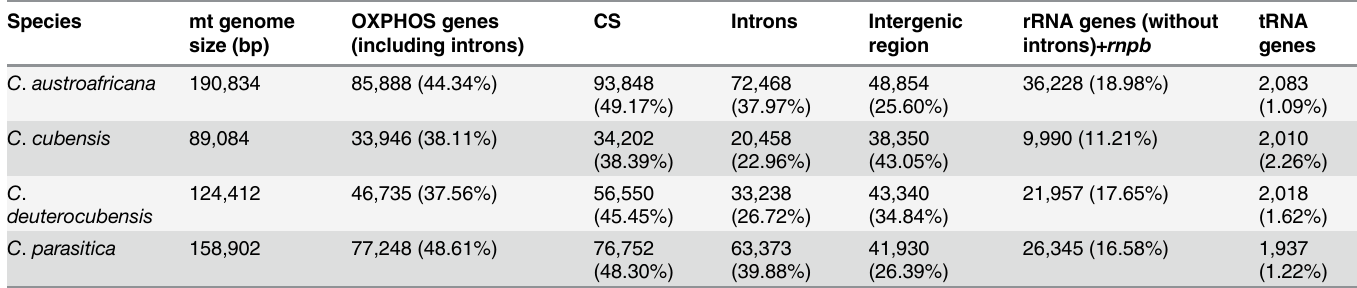
Table 4. Total sizes of genes, coding sequences, and intergenic regions of C . austroafricana , C . cubensis , C . deuterocubensis and C . parasitica mt genomes. The size of the intergenic region was calculated by subtracting the sum total of the 14 OXPHOS genes, tRNAs , rRNAs and rnpb from the mt genome